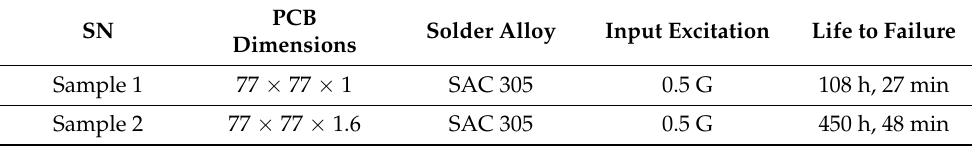
Table 4. SAC 305 Life Predicted through